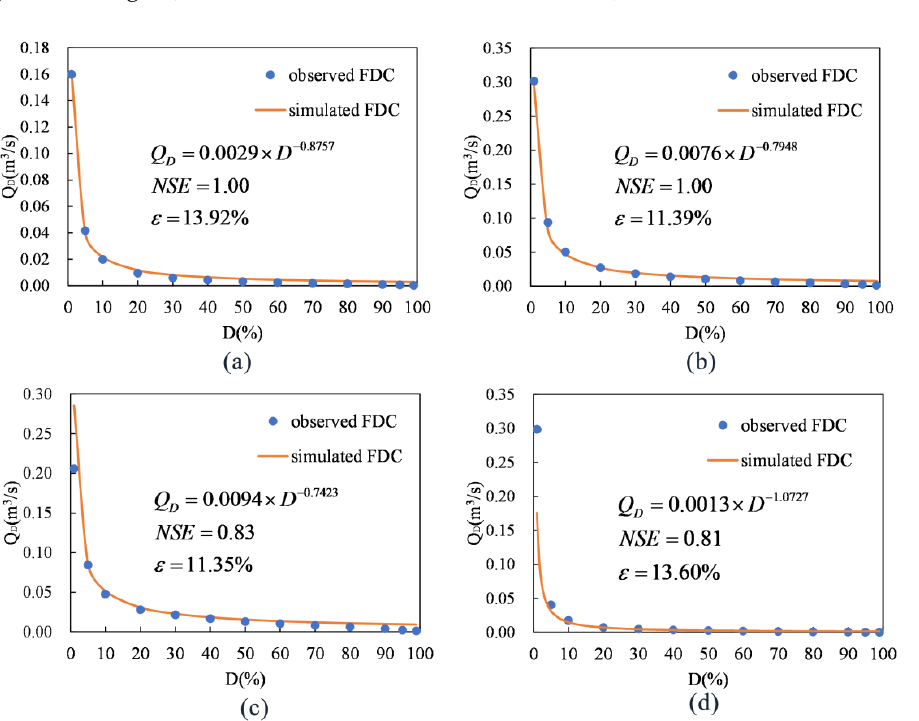
Figure 6. The simulated and observed FDCs of eight basins from different NSE gradient ranges: ( a ) Dapoling (ID. 8), ( b ) Zhangchong (ID. 17), ( c ) Hengtangcun (ID. 45), ( d ) Lixin (ID. 6), ( e ) Zhongtang (ID. 2), ( f ) Xiagushan (ID. 4), ( g ) Laoshikan (ID. 41) and ( h ) Hongtian (ID. 61).